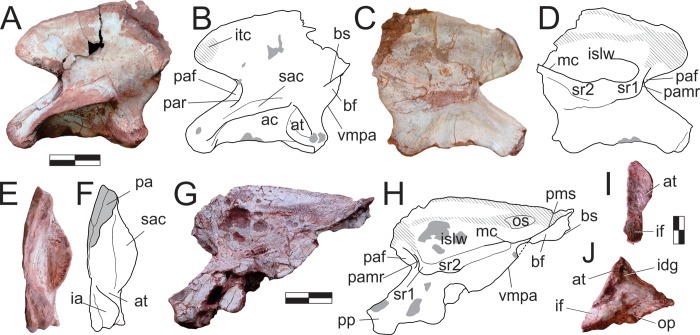
Pampadromaeus barberenai (ULBRA-PVT016), pelvic girdle.Photographs (A,C,E,G,I-J) and drawings (B,D,F,H) of the pelvic elements. Left ilium in (A-B) lateral, (C-D) medial, and (E-F) ventral views. Right ilium in (G-H) medial views. Left ischium in (I) proximal and (J) lateral views. Abbreviations: ac, acetabulum; at, antitrochanter; bf, brevis fossa; bs, brevis shelf; ia, ischial articulation; idg, ischial dorsal groove; if, ischial fossa; itc, M. iliotibialis cranialis scar; islw, lateral wall of the intercostal space; mc, medial crest; op, obturator plate; os, second sacral transverse process attachment area; pa, pubic articulation; paf, preacetabular fossa; par, iliac preacetabular ridge; pamr, iliac preacetabular medial ridge, pms, posteromedial shelf; pp, pubic peduncle; sac, supracetabular crest; sr, sacral rib articulations; vmpa, ventral margin of the postacetabular ala. Grey areas indicate parts broken or covered by sediment; hatched indicates muscle insertions areas. Scale bar = 2 cm (A-H); 1 cm (I-J).